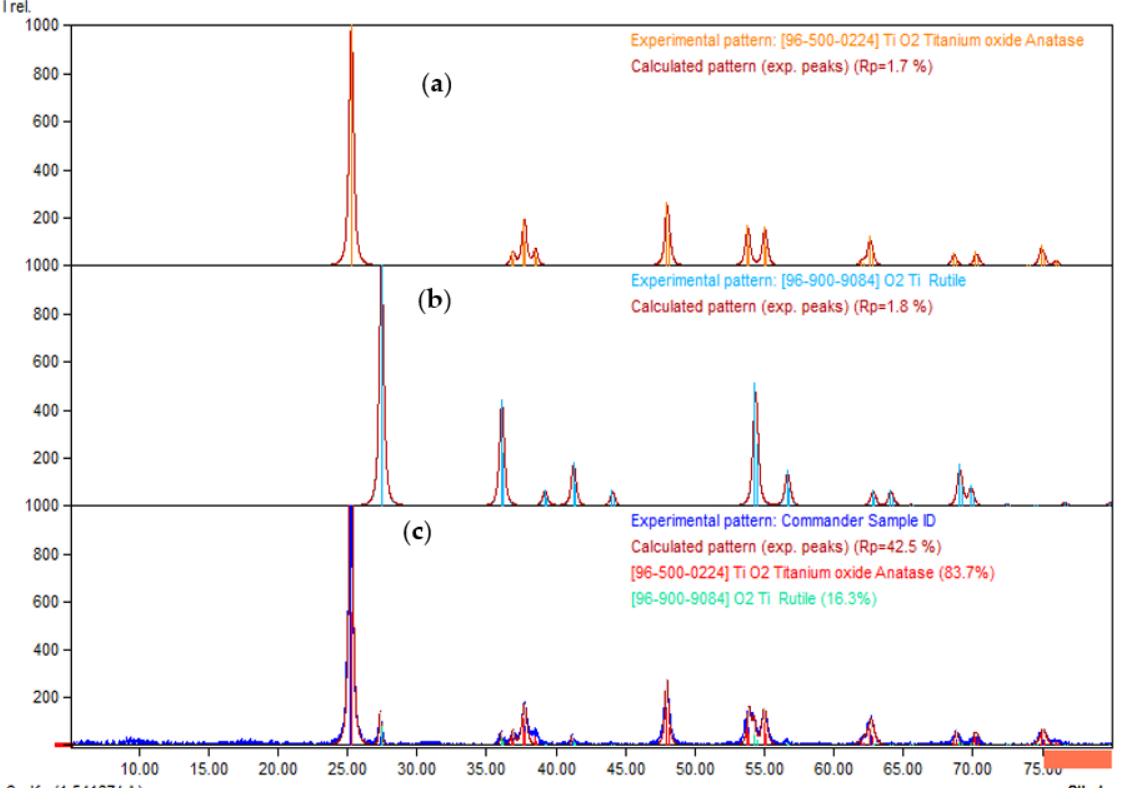
Figure 2. XRD patterns for TiO 2 photocatalysts ( a ) TiO 2 anatase-phase database. ( b ) TiO 2 rutile phase database. ( c ) XRD experimental pattern of TiO 2 photocatalyst.